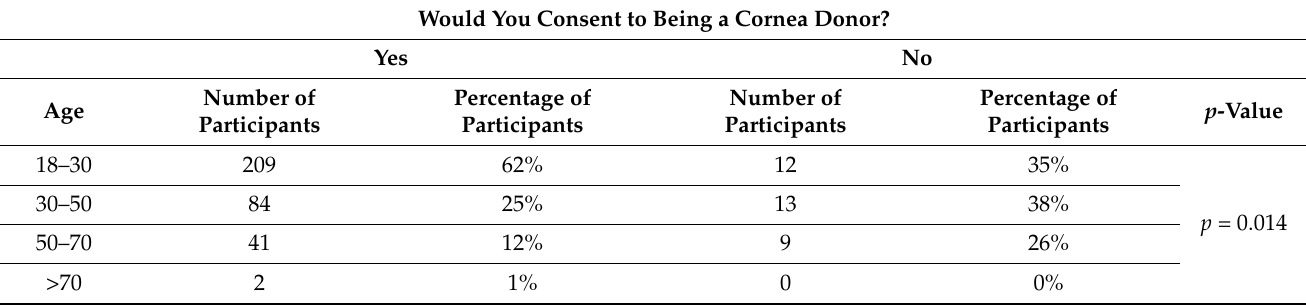
Table 4. Association between willingness to donate corneal tissue and socio-demographic data in health professionals.